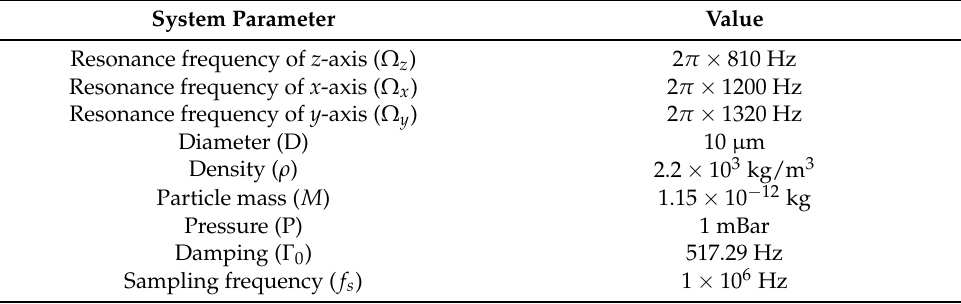
Table 1. Parameters of the optical trap simulation